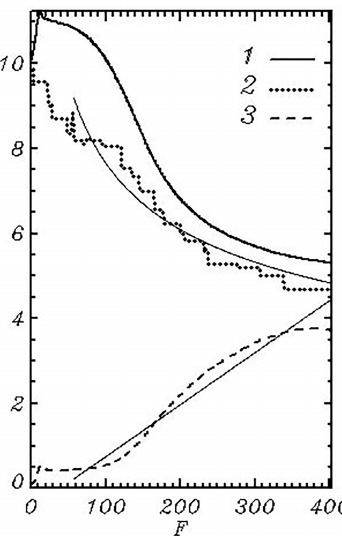
Figure 14. Time evolution of weighted frequency ω w (1) (Eq. 34), the spectral peak frequency ω p = k 1 / 2 p (2) and full energy E (3) (Eq. 28). Thin curves correspond to the empirical dependences for the peak wave number and energy. F is a distance passed by the spectral